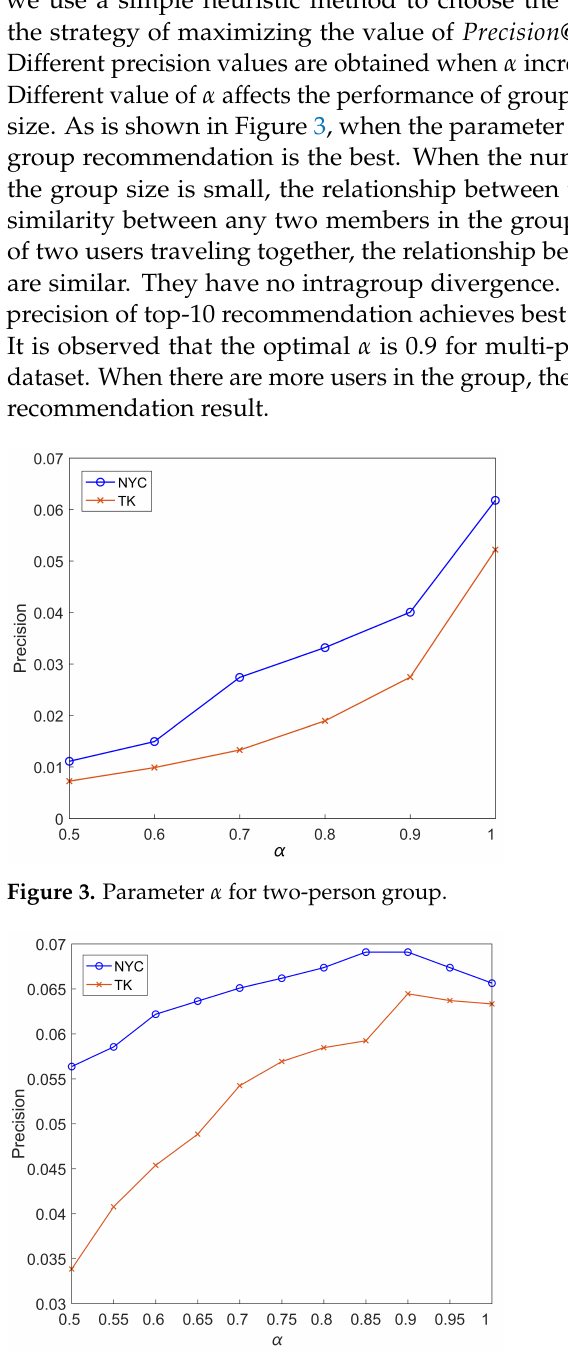
Figure 4. Parameter α for multi-person